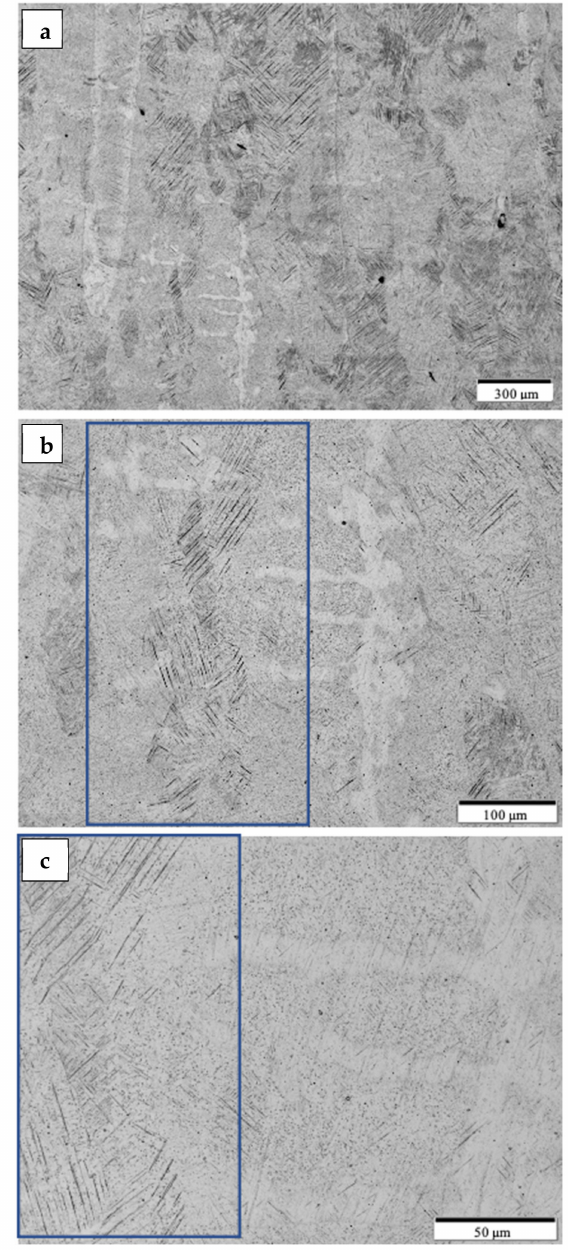
Figure 8. Optical micrographs of as-built DOE cubes from the build middle. ( a ) Low magnification. ( b ) Medium magnification. Alpha-prime enclosed in the blue rectangle. ( c ) High magnification. Alpha-prime enclosed in the blue